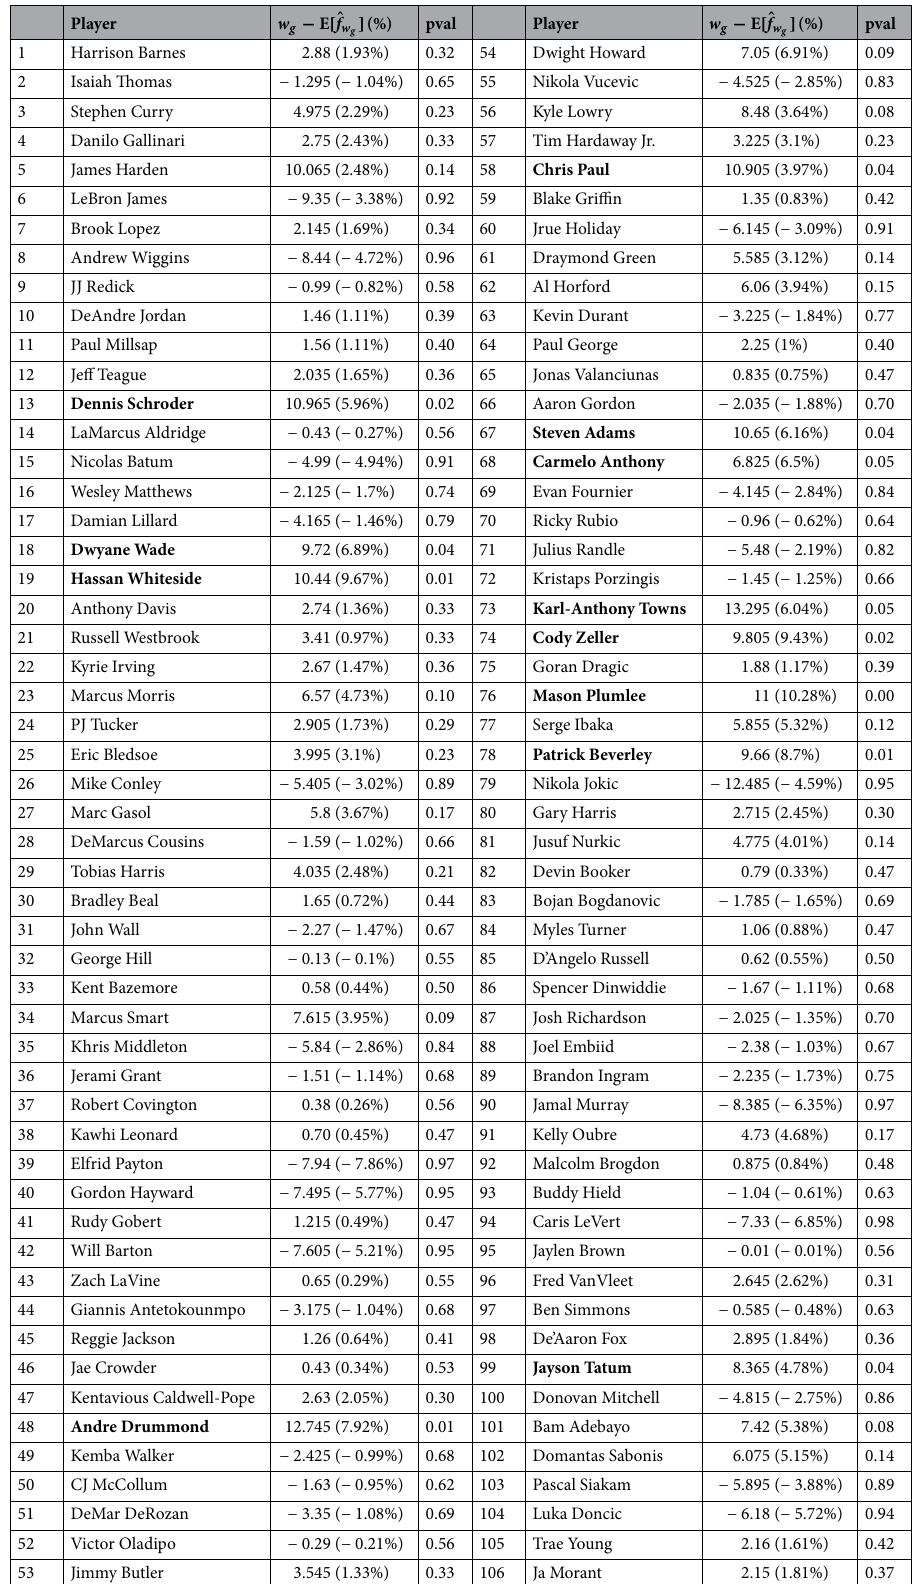
Table 3. Net whistle gain for individual players. Significant values are in